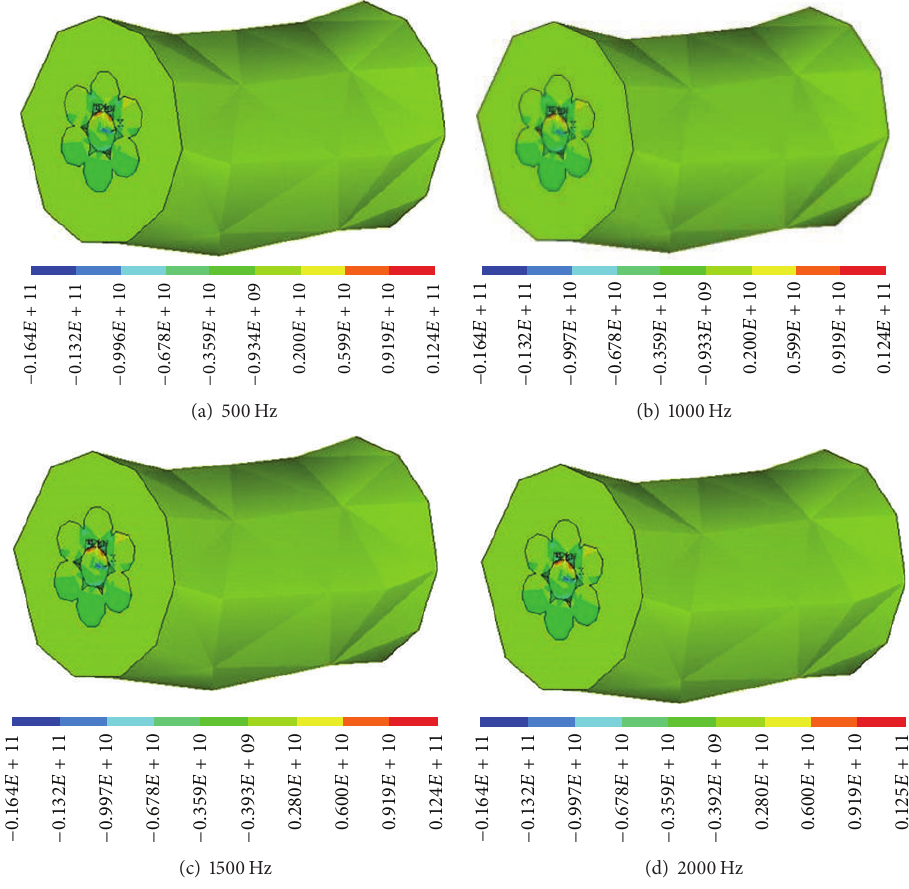
Figure 4: The incentive displacement of 0.5 mm.